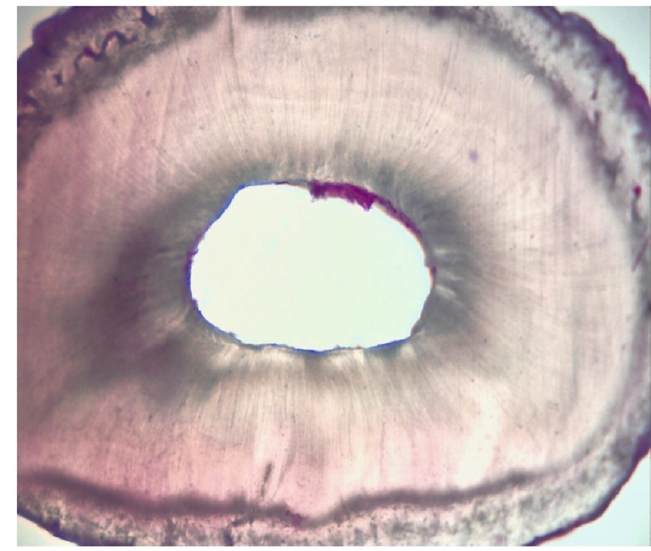
Tables 3 and 4 score of the degree of dissolution of the debris.